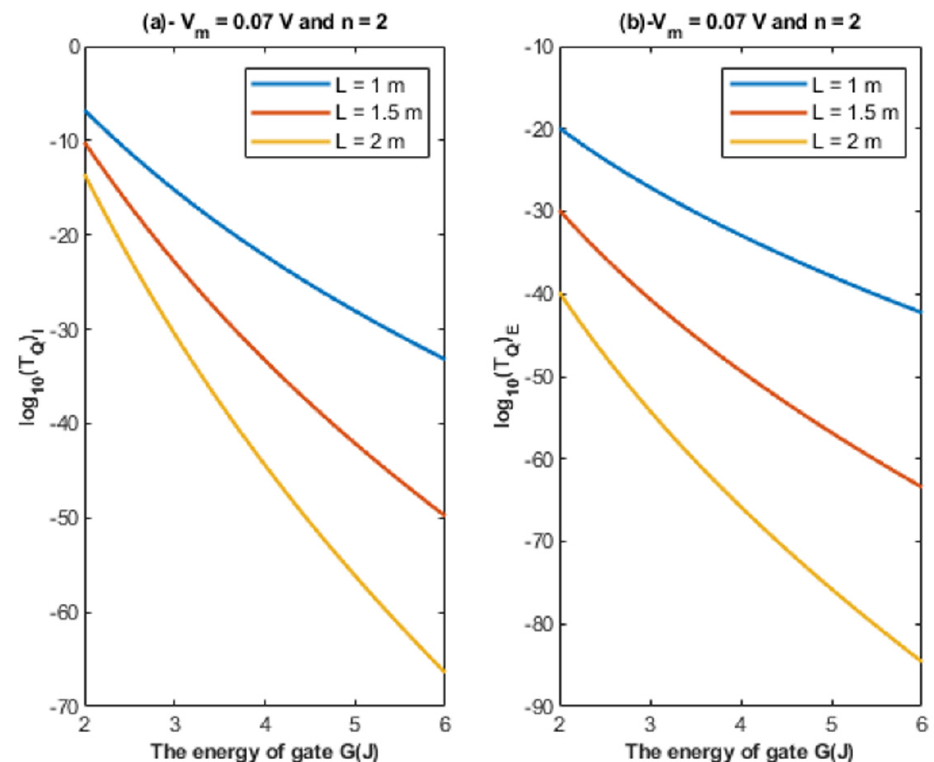
( T ) and the Q 10 I log ( ) T and ( T ) 10 Q I , respectively. The relationships are Q 10 E log ( ) T , respectively. The 10 Q E